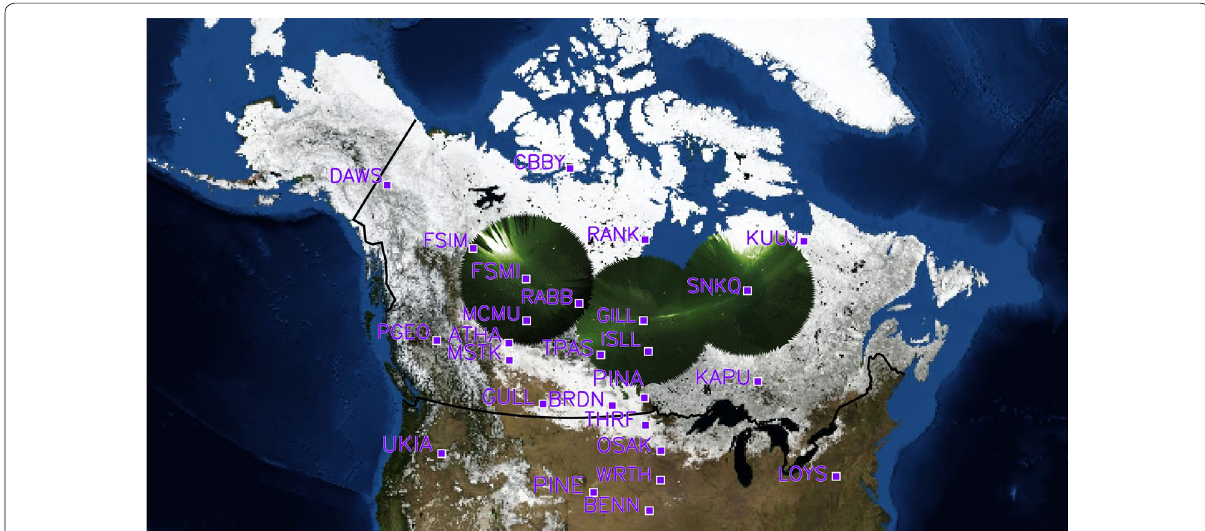
Fig. 1 Locations of the ground magnetometers from the CARISMA, THEMIS, CANMOS and McMAC magnetometer chains (for details see text). Overplotted in the figure are data from the GILL THEMIS ASI at 06:04:20 UT which approximately correspond to the time of auroral brightening in this substorm